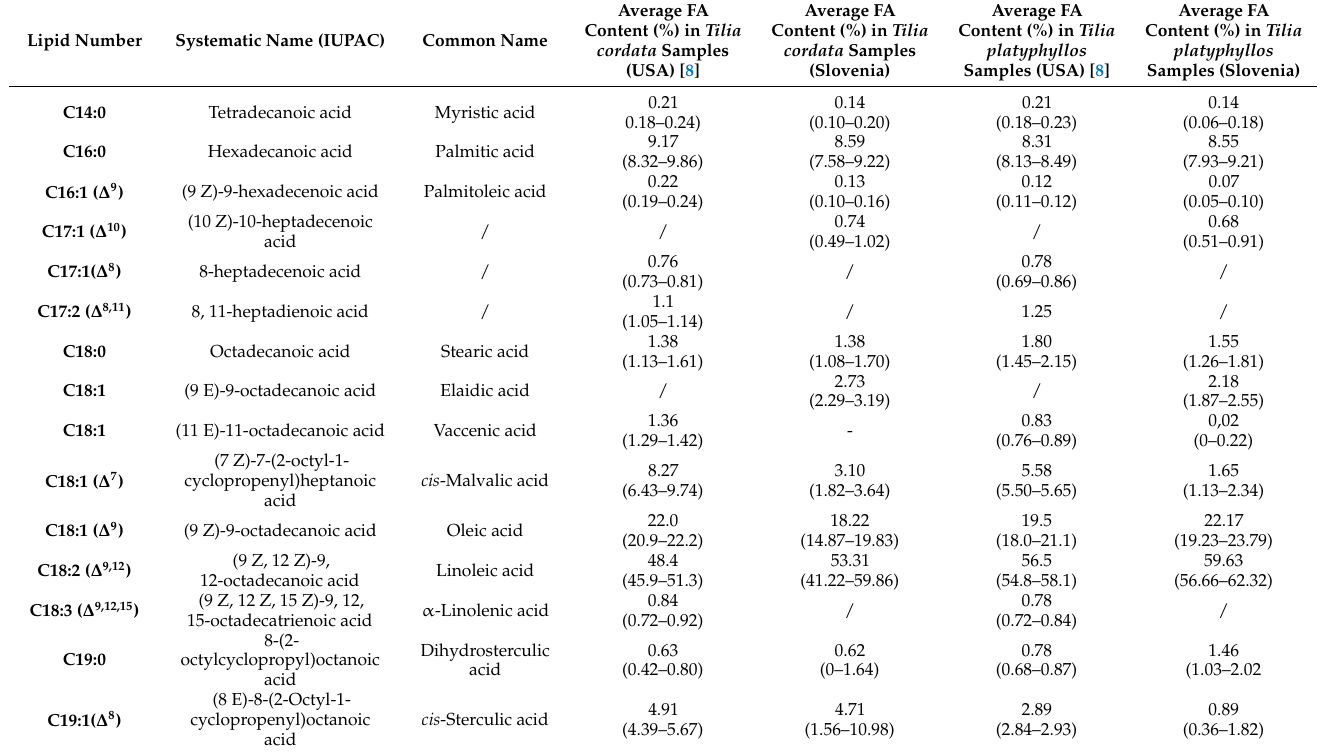
Table 2. Content of fatty acids in Tilia seed oil in Slovenian samples compared with samples from the USA